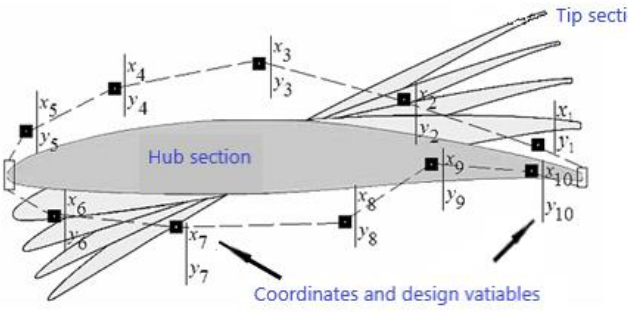
Figure 2. Schematic diagram of airfoil shape with twenty shape design variables.